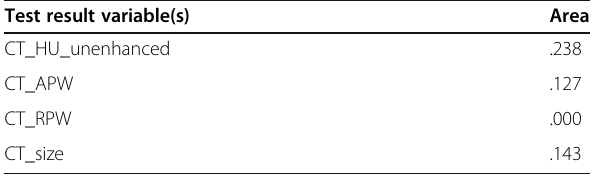
Protocol for MRI MR imaging was performed in 20 patients using a 1.5 T unit (Philips GyroscanIntera) with a phased-array body coil. T1-weighted spin echo axial images were acquired with a TR of 425 ms and a TE of 15 ms. T2-weighted Table 3 Area under the curve of CT diagnostic value in benign lesions Test result variable(s)